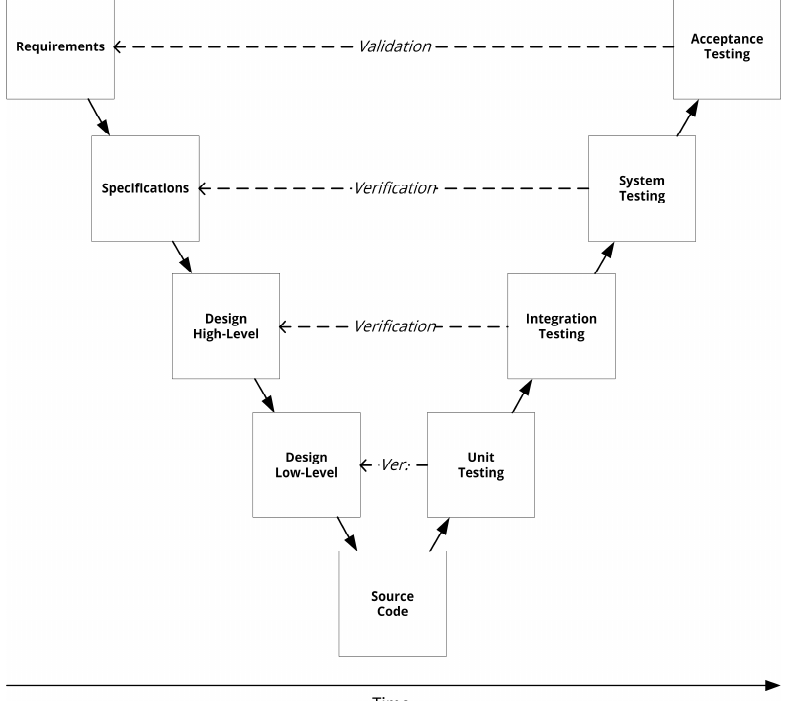
Figure 4. Traditional V-model used to describe the development lifecycle of an unspecified system. The representation is based on the V-model shown in [18], extended by verification and validation steps and the time